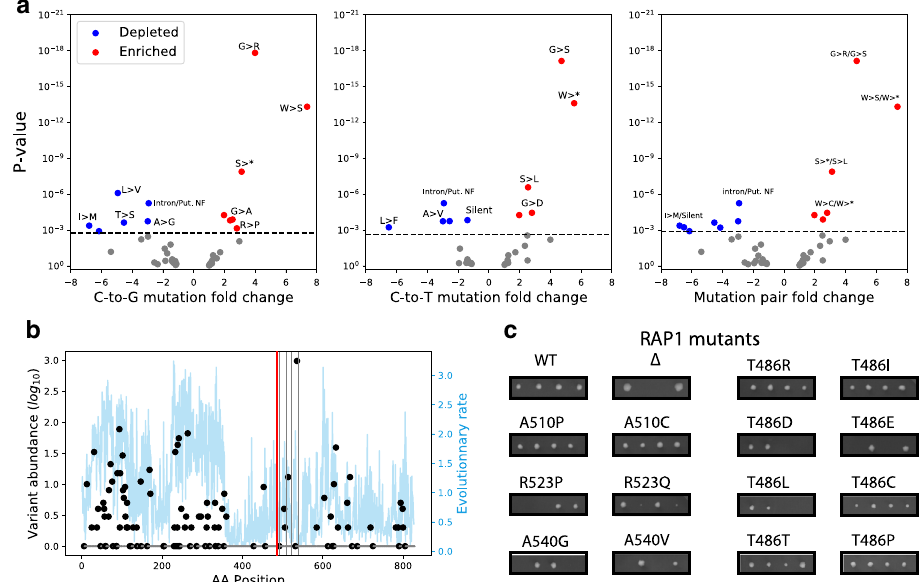
Fig. 5 GNE mutations are enriched for speci fi c amino acid substitution patterns and identify critical sites for protein function. a Fold depletion and enrichment volcano plots for the most probable mutations induced by GNEs in the screen. Enrichment and depletion values were calculated by comparing the relative abundance of each mutation among GNEs and NSGs using two-sided Fisher ’ s exact tests. Mutation patterns signi fi cantly depleted are shown in blue, while those that are enriched are in red. The signi fi cance threshold was set using the Holm – Bonferroni method at 5% FDR to correct for multiple testing and is shown as a dotted gray line. b Protein variant frequency among 1000 yeast isolates (black dots) and residue evolutionary rate across species (blue line) for RAP1 . The target site for the GNEs targeting T486 is highlighted by a red line while the other detected GNEs target sites are shown by a gray line. c Tetrad dissections con fi rm most RAP1 GNE induced mutations indeed have strong fi tness effects, as well as other substitutions targeting these sites. Source data are available in the Source Data fi